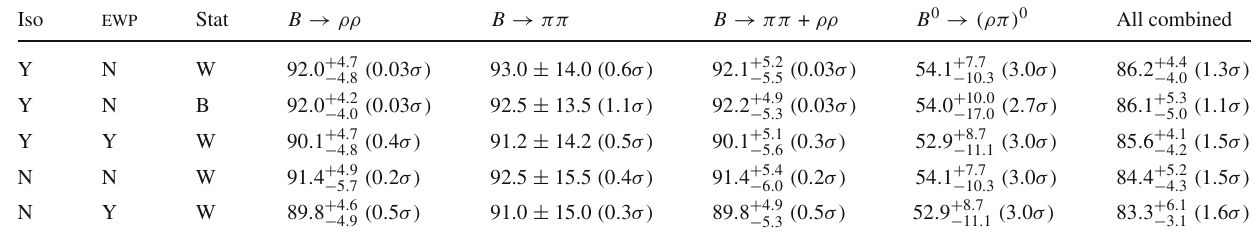
Dalitz analysis). In the “ ewp ” column, Y indicates that a contamina- tion from Δ I = 3 / 2 electroweak penguins is included as discussed in Sect. 4.1.1, whereas N corresponds to setting these penguin contri- butions to zero. In the “Stat” column, B corresponds to the bootstrap approach and W to the Wilks-based one. For each channel or combina- tion of channels, the deviation with respect to the indirect determination α ind is indicated within